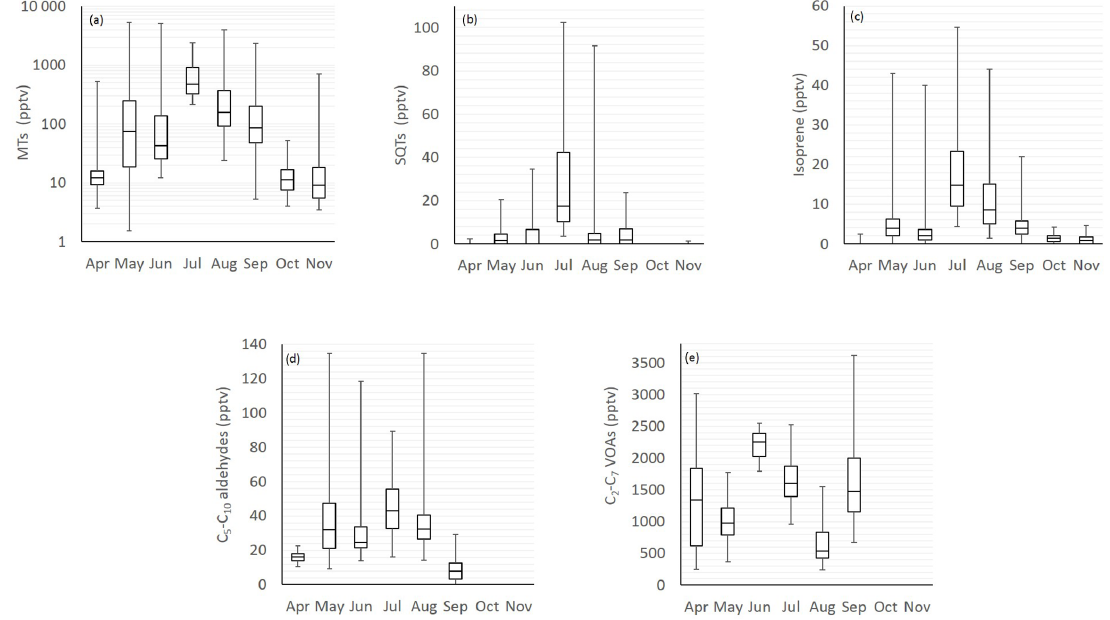
Figure 1. Monthly mean box and whisker plots of (a) monoterpenes (MTs), (b) sesquiterpenes (SQTs), (c) isoprene, (d) C 5 –C 10 aldehydes and (e) C 2 –C 6 volatile organic acid (VOA) concentrations. The boxes represent first and third quartiles and the horizontal lines in the boxes the median values. The whiskers show the highest and lowest observations. Note that the y axes for the MTs are in a logarithmic